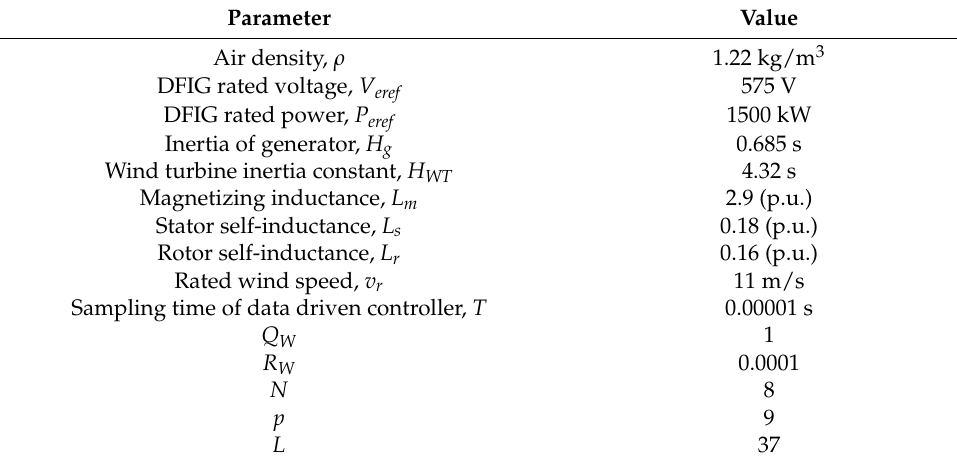
Table 1. Simulation parameters of DFIG-based wind turbine. Parameter Value Air density, ρ 1.22 kg/m 3 DFIG rated voltage, V eref DFIG rated power, P eref Inertia of generator, H g Wind turbine inertia constant, H WT Magnetizing inductance, L m 2.9 (p.u.) Stator self-inductance, L s 0.18 (p.u.) Rotor self-inductance, L r 0.16 (p.u.) Rated wind speed, v r 11 m/s Sampling time of data driven controller, T 0.00001